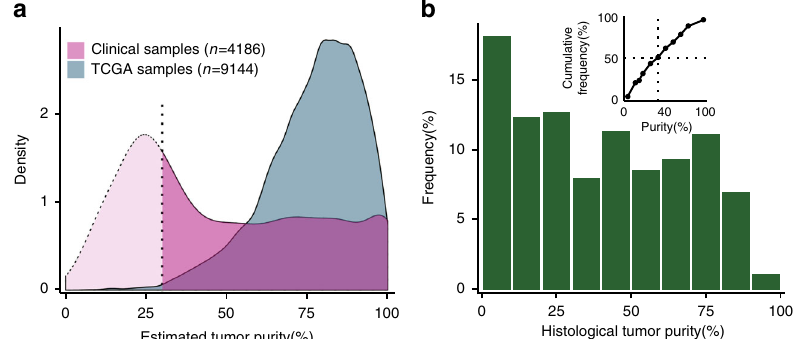
Fig. 4 Distribution of tumor purity in clinical samples. a The distributions of tumor purity estimates in our cohort and the TCGA samples are shown after kernel density smoothing. It was possible to reliably estimate purity (Supplementary Data 3) for about half the cases in our cohort (Methods section); purity estimates for the TCGA samples are taken from Aran et al. 23 . Below 30%, the estimates are less reliable, as indicated by the dotted line. b Histological tumor purity estimates of 3697 lung cancer biopsy specimens obtained in daily clinical practice described in a related cohort 24 . The cumulative distribution (inset) shows that half of the samples had purity <